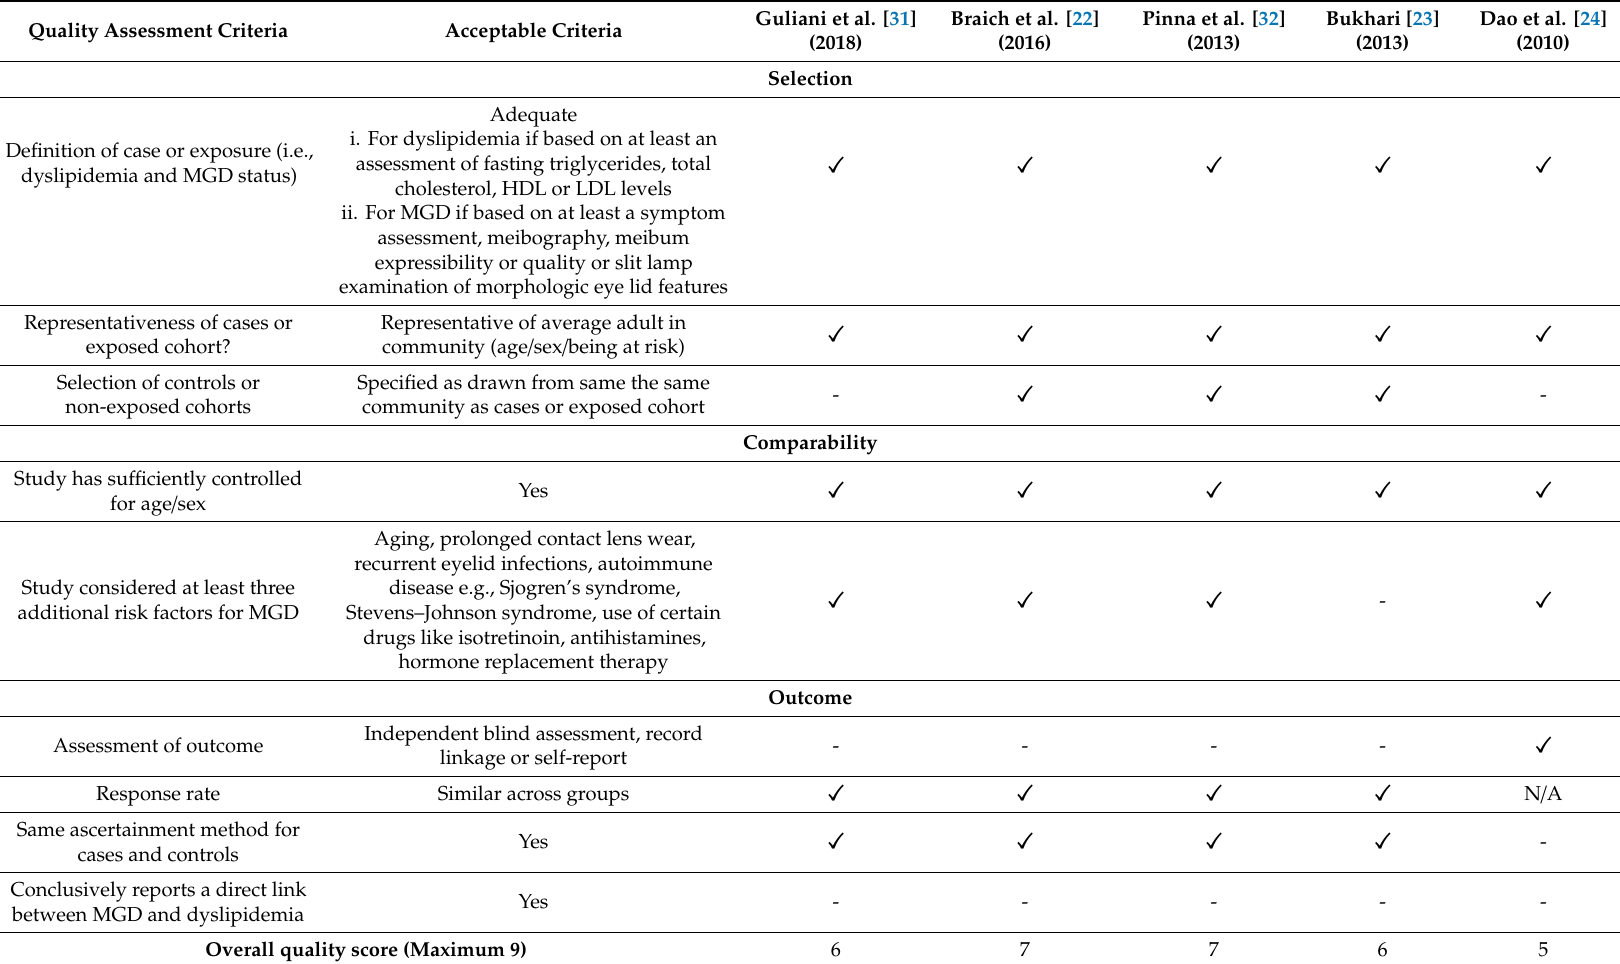
Table 2. Modified Newcastle–Ottawa scale for assessment of the quality of included